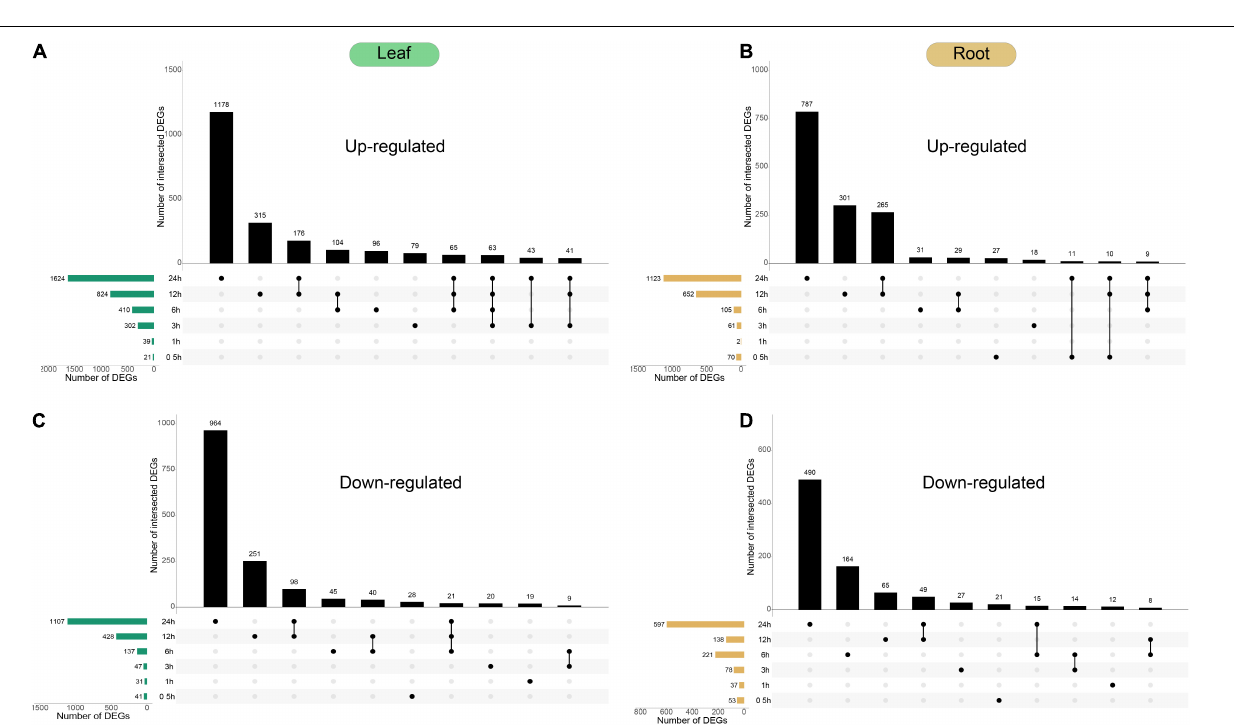
FIGURE 4 | Temporal dynamics of Capsicum annuum L. transcriptome during cold treatment. (A–D) Forty-day-old Capsicum annuum L. plants were subjected to cold stress at 10 ◦ C and harvested at the given time points for transcriptome analysis. UpSet plots of the number of up-regulated and down-regulated genes [cut-off threshold, | log2(FC)| ≥ 2; FDR < 0.01] demonstrated different temporal expression patterns (top bar graphs). The total numbers of up-regulated and down-regulated genes at each of the time points are shown on the